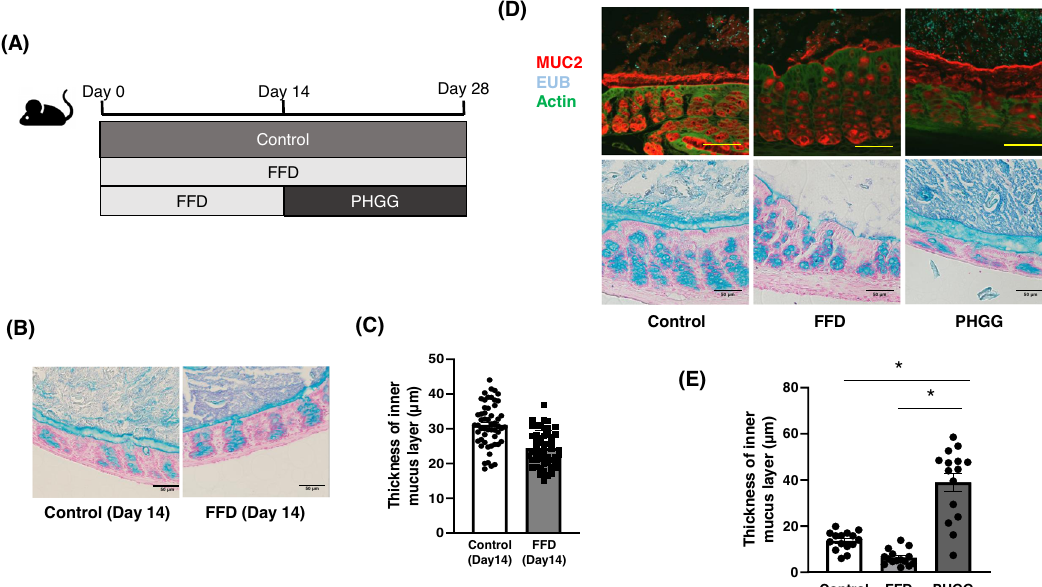
Fig. 1 Thickness of the colon mucus layer in mice. A Schematic diagram of the mouse model of dietary fi ber intake. B Thickness of the colon mucus layer in mice. Alcian blue staining of colon sections at day 14. Scale bars, 50 μ m. C Measurement of the colonic mucus layer thickness of day 14 mice. The colonic mucus layer thickness of each group was measured at nine points, and the means were compared. D Fluorescent immunostaining of MUC2 in the colon of mice and alcian blue staining of sections of the colon at day 28. Scale bars, 50 μ m. E Measurement of the colonic mucus layer thickness. The colonic mucus layer thickness of each group was measured at nine points, and the means were compared. Error bars represent the SEM. (* p < 0.01). FFD fi ber-free diet, PHGG partially hydrolyzed guar gum, MUC2 mucin